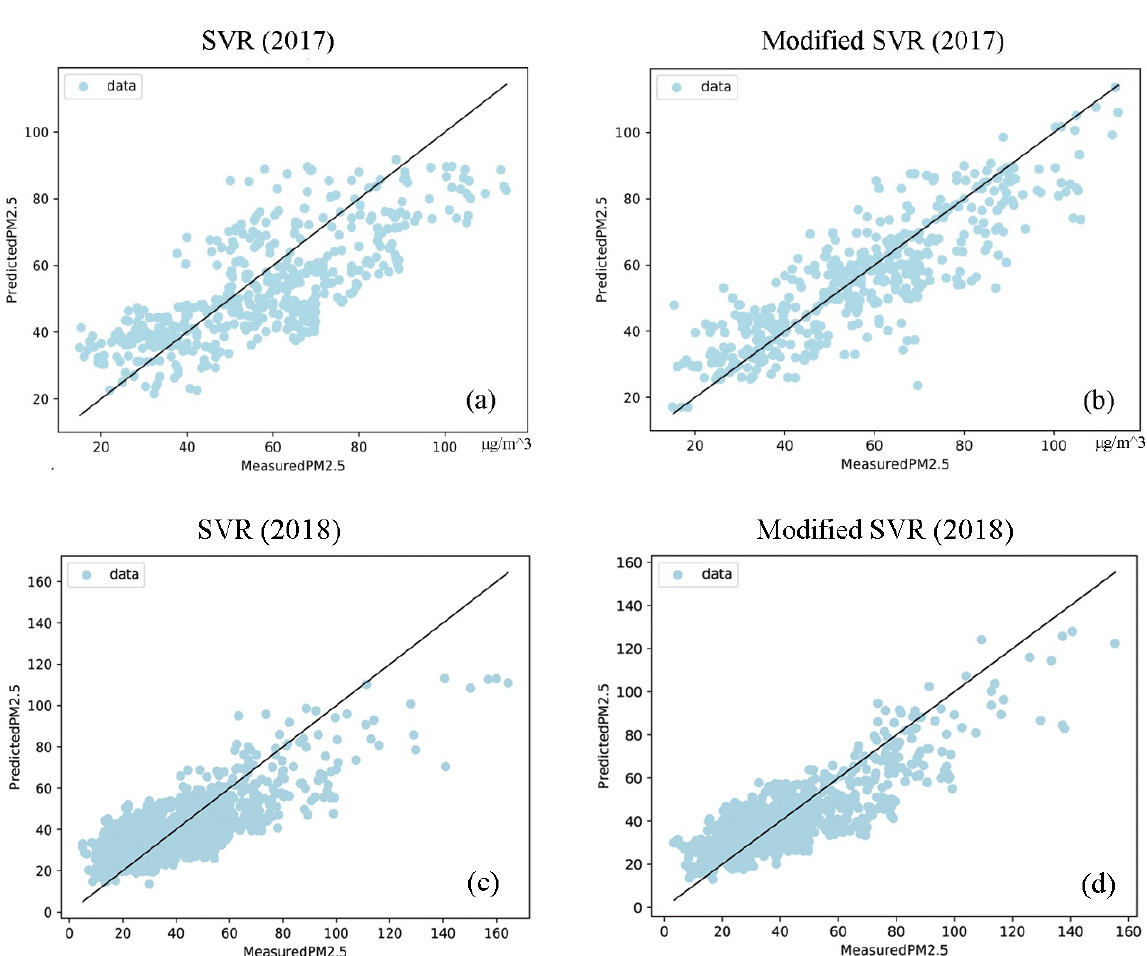
Figure 7. The scatterplots of cross validation results for SVR ( a ) and Modified SVR ( b ) models in 2017, SVR ( c ) and Modified Scheme 2018. ( d ) are shown in the figure. The horizontal axis represents the measured true PM 2.5 values and the vertical axis represents the predicted PM 2.5 obtained from the regression models. The black lines are the 1:1 reference line.